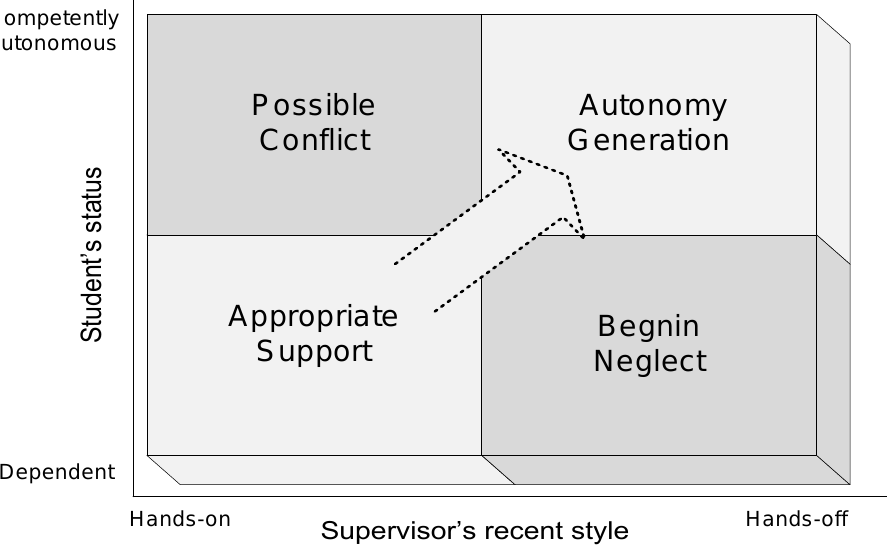
Figure 3 Dynamic alignment model (Gurr, 2001,